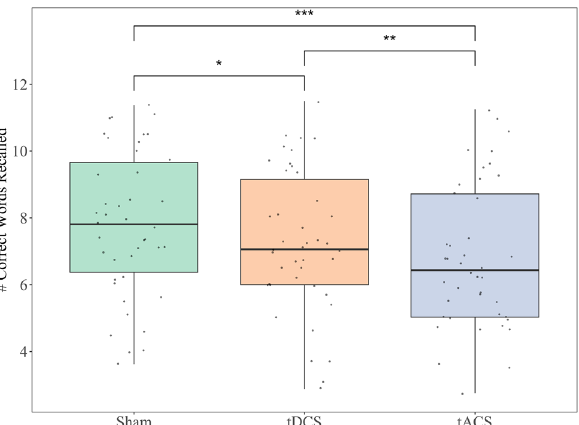
Figure 3. Average number of correct words recalled during each stimulation type with vertical lines representing standard error. *p ≤ 0.05; ** p ≤ 0.01; *** p ≤